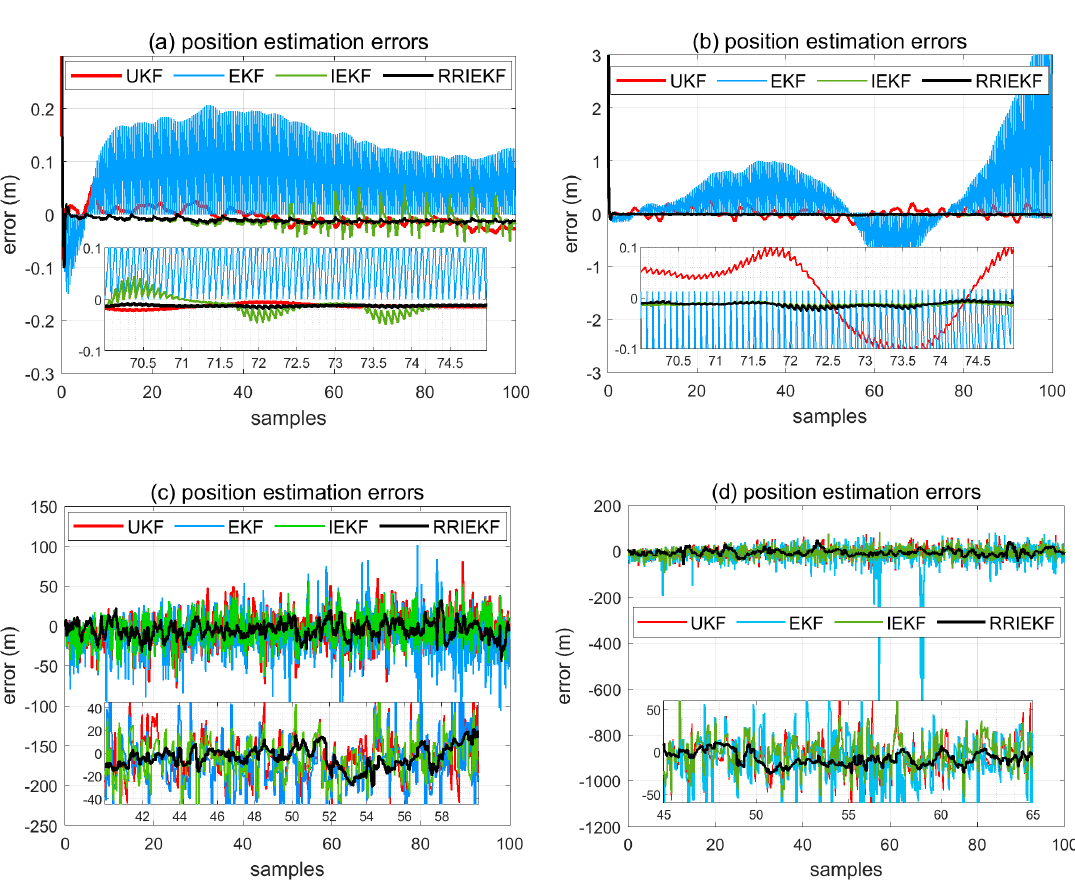
Figure 7. Position estimation